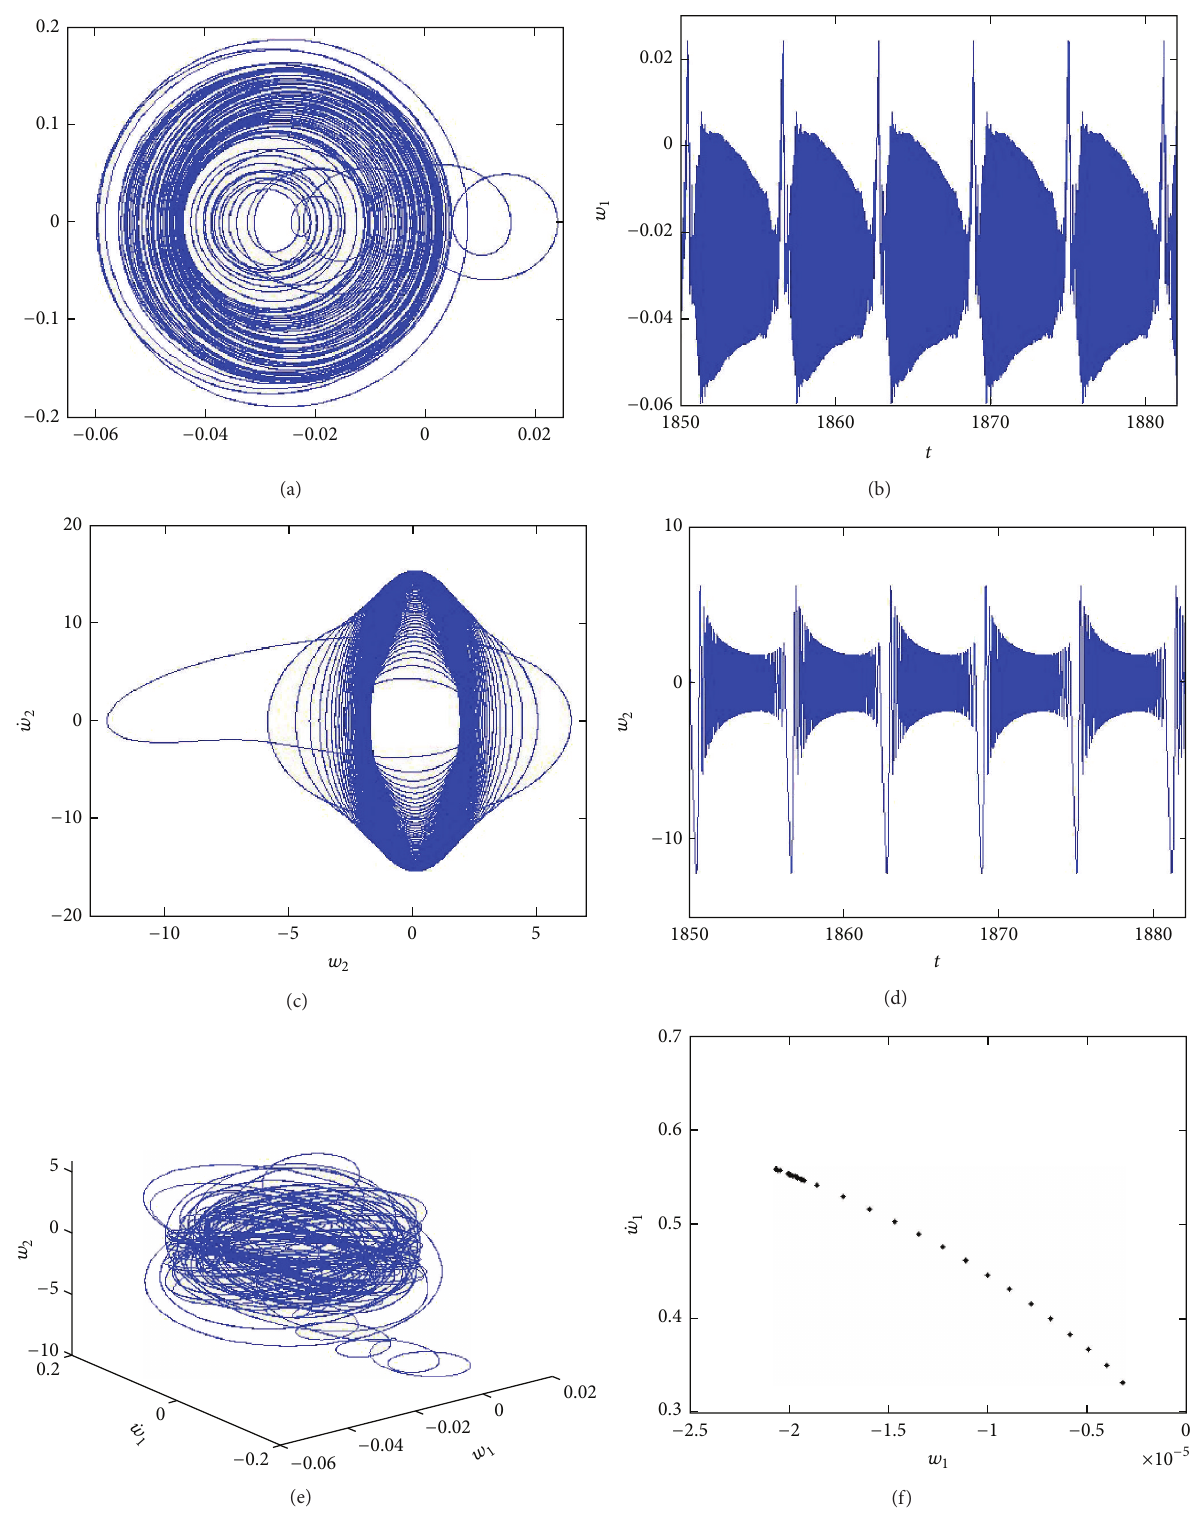
Figure 5: The multiple-periodic motion of the FGM cylindrical panel occurs when the magnitude of the in-plane excitation is taken to be 6.70 × 10 7 . The volume fraction index is taken to be 0.5. The Mach number is taken to be